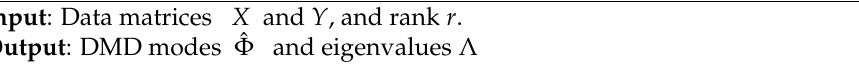
Algorithm 2 Alternative exact